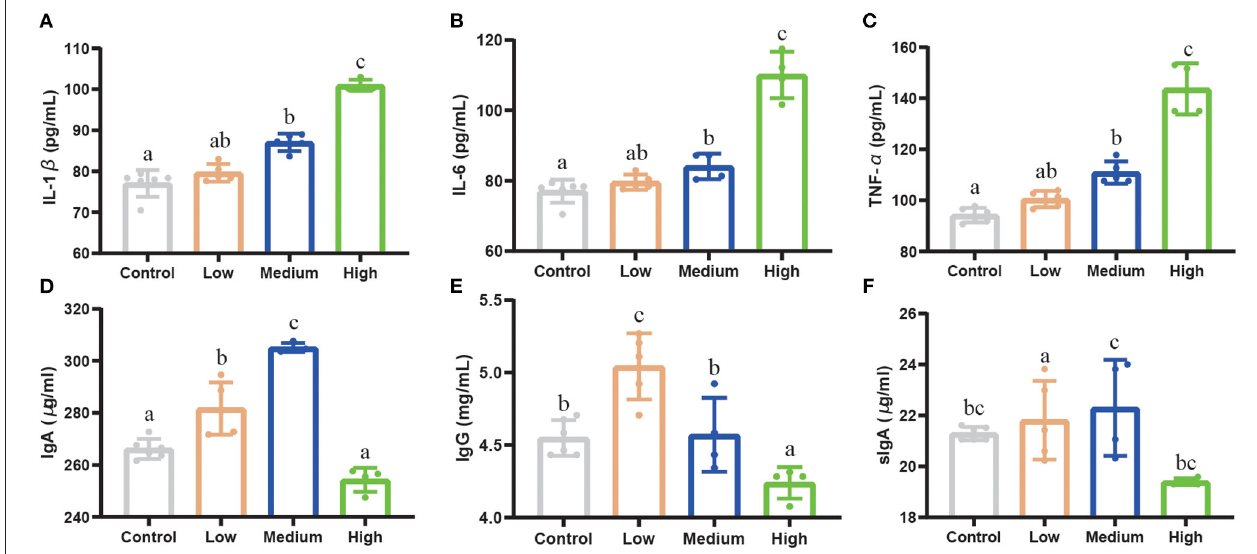
FIGURE 6 | The effect of Clostridium perfringens treatment on inflammatory cytokines and immunoglobulin of mice. (A) IL-1 β . (B) IL-6. (C) TNF- α . (D) IgA. (E) IgG. (F) sIgA. Results are presented as mean ± SD. a , b , c Means values with dissimilar letters were significantly different ( P <